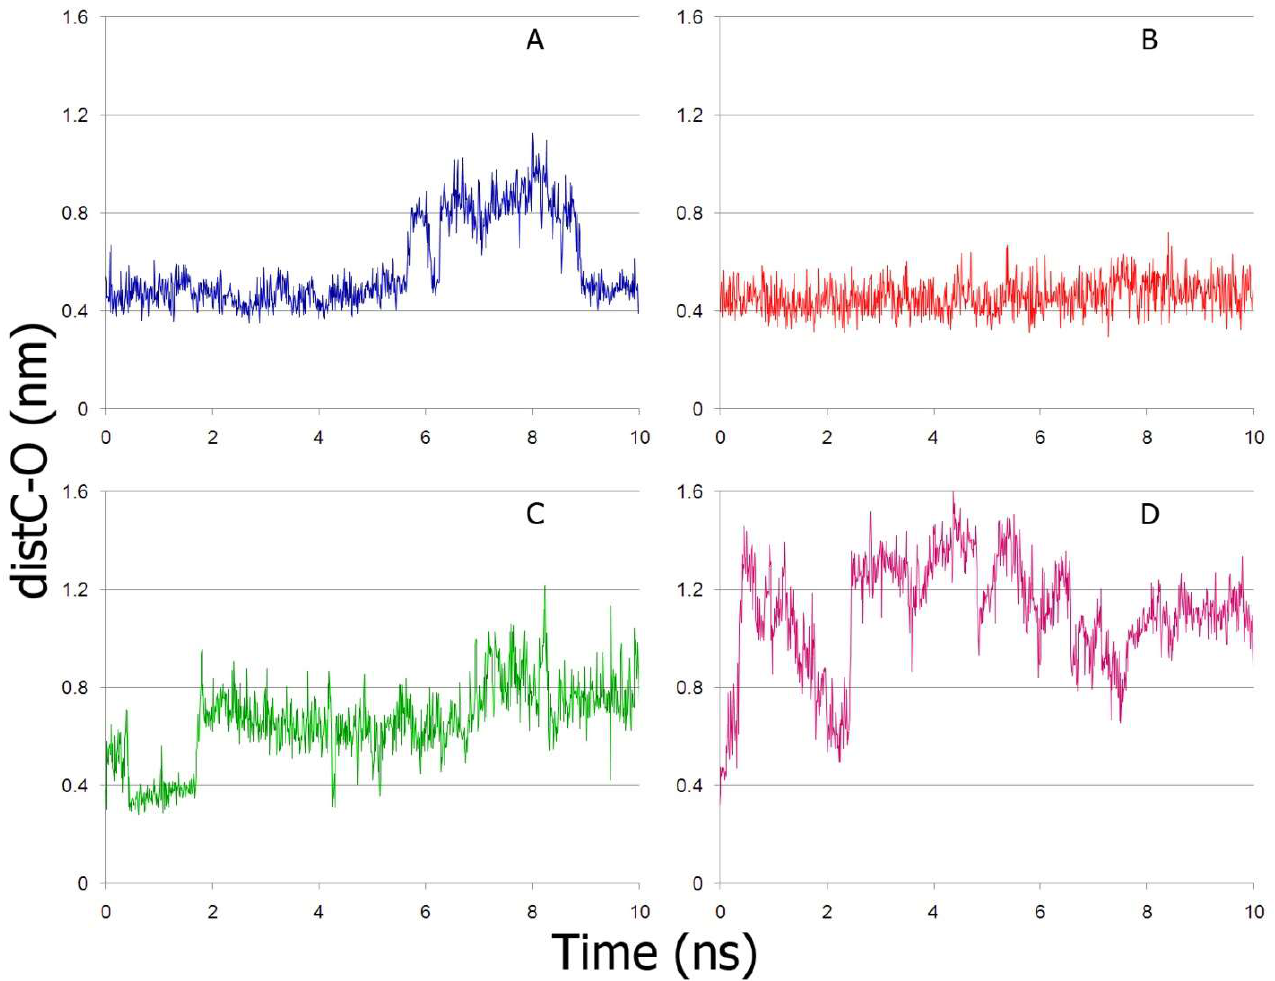
Figure 6. Time change of the distance (distC-O) between the carbonyl carbon of NPA and the hydroxyl oxygen atom of catalytic amino acids of esterase and pseudo-esterase activity of BSA according to molecular dynamics (MD) simulation. ( A ) Sudlow site I and catalytic tyrosine Tyr149, ( B ) Sudlow site II and catalytic Tyr410, ( C ) site III and catalytic Tyr137, ( D ) site III and catalytic Ser192.